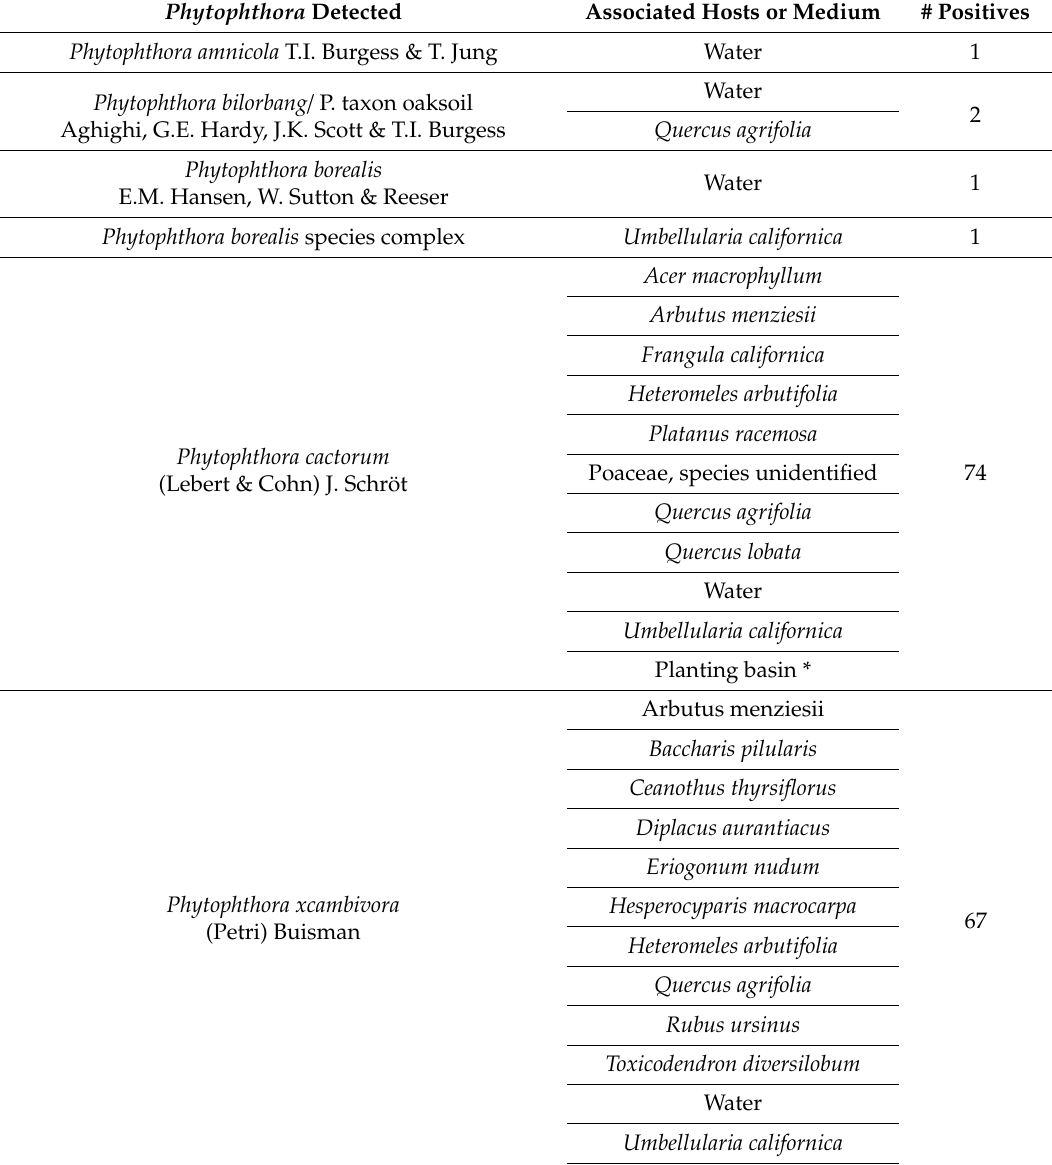
Table 1. Phytophthora detections from samples collected on the San Francisco PublicUtilities Commission (SFPUC) watershed lands in Alameda, San Mateo, and Santa Clara Counties between 2014 and